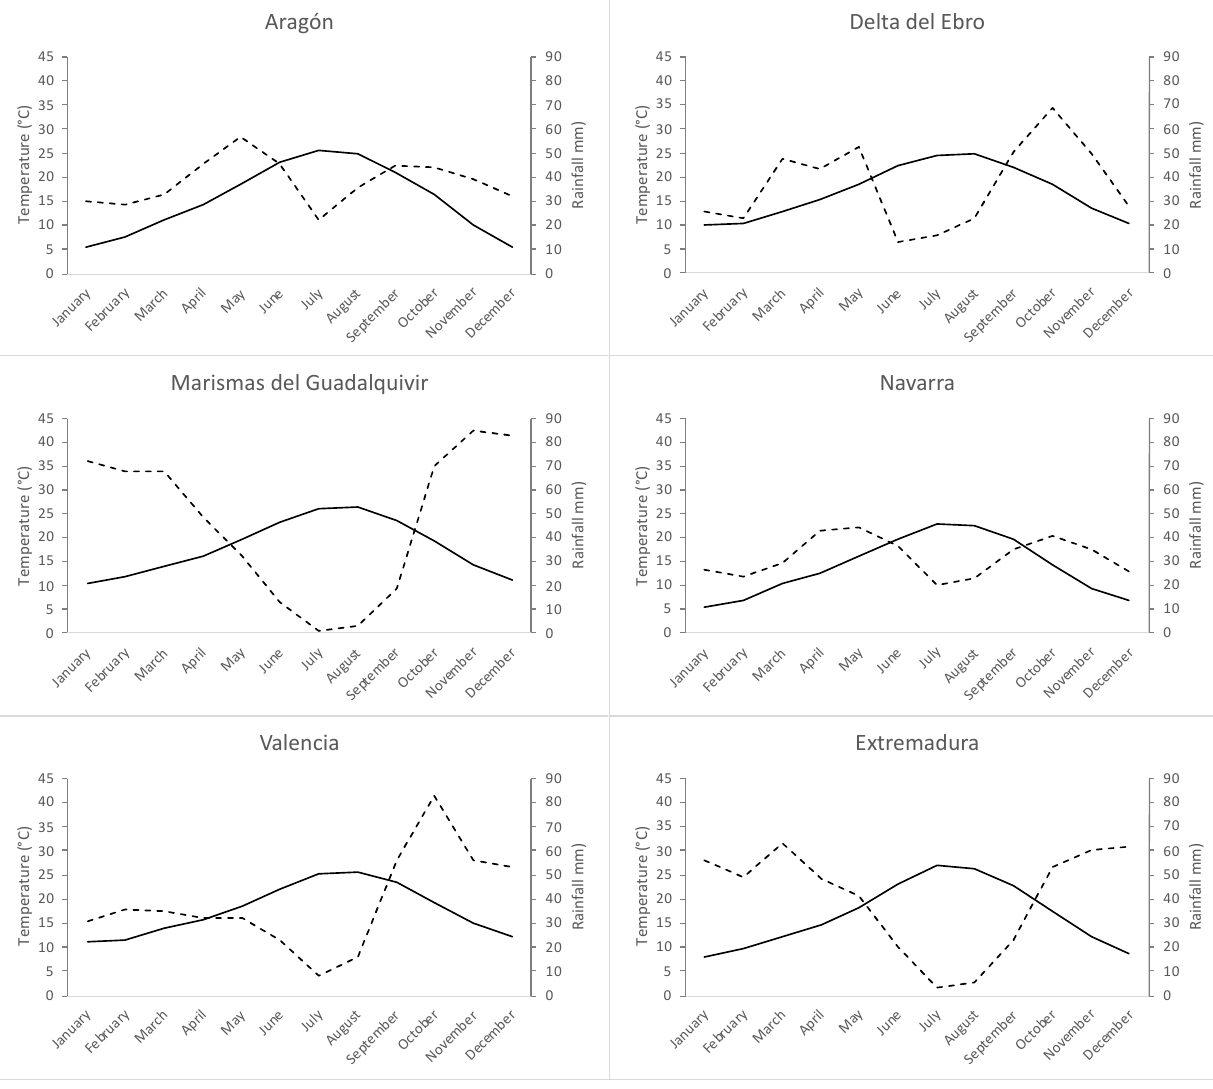
Figure 2. Ombrothermic diagrams of the six Spanish main rice areas. Solid line: mean temperature; dashed line: rainfall. Data are from a recent 20–30 ‐ year series for each rice area.